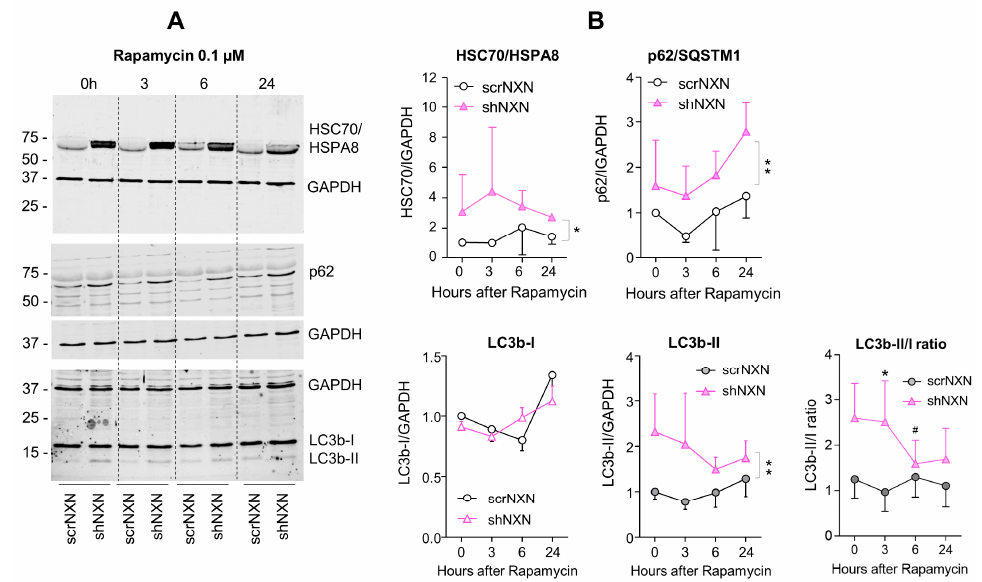
Figure 6. Western blot analysis of autophagy markers upon low-dose rapamycin stimulation. ( A , B ) Western blots show the time courses of HSC70/HSPA8, SQSTM1/p62 and LC3b and the LC3b-II/I ratio after stimulation with 0.1 µ M rapamycin. Blots were sequentially developed, and infrared images superimposed. Intensities were normalized for loading and show the mean + SD of 3 experiments. Statistical comparison by Wilcoxon matched pairs rank test. Asterisks indicate differences between groups. * p < 0.05; ** p < 0.01. The # indicates a significant different versus baseline. Raw Western blot data in Supplementary Figures S5 and S6.